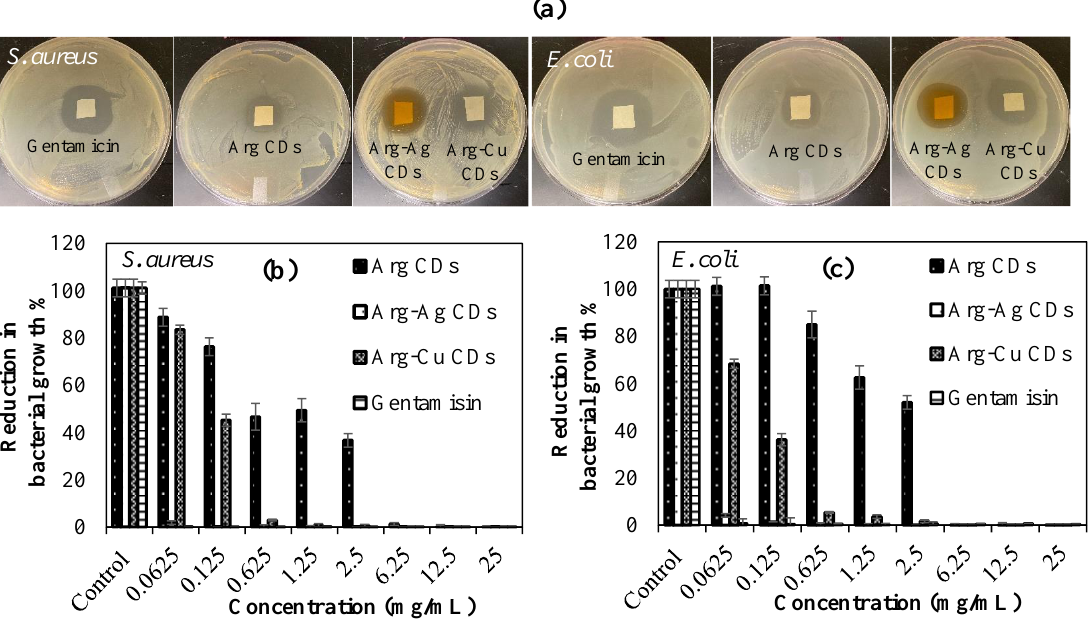
Figure 6. ( a ) Inhibition zones of 10 mg Arg CDs, Arg-Ag CDs, and Arg-Cu CDs suspended in 50 µ L phosphate bu ff er solution (PBS) and 1 mg gentamicin in 20 µ L PBS against S. aureus and E. coli using the disc di ff usion test, ( b , c ) the bacterial inhibition % of Arg CDs, Arg-Ag CDs, and Arg-Cu CDs at di ff erent concentrations for S. aureus and E. coli using the microdilution test. (Gentamicin was used as the control). Table 1. Inhibition zone (mm) of 10 mg Arg CDs, Arg-Ag CDs, and Arg-Cu CDs suspended in 50 µ L PBS and 1 mg gentamicin in 20 µ L PBS against S. aureus and E. coli using the disc di ff usion test and minimum inhibition concentration (MIC) and minimum bactericidal concentration (MBC) values of Arg CDs, Arg-Ag CDs, and Arg-Cu CDs against S. aureus and E. coli using the microdilution